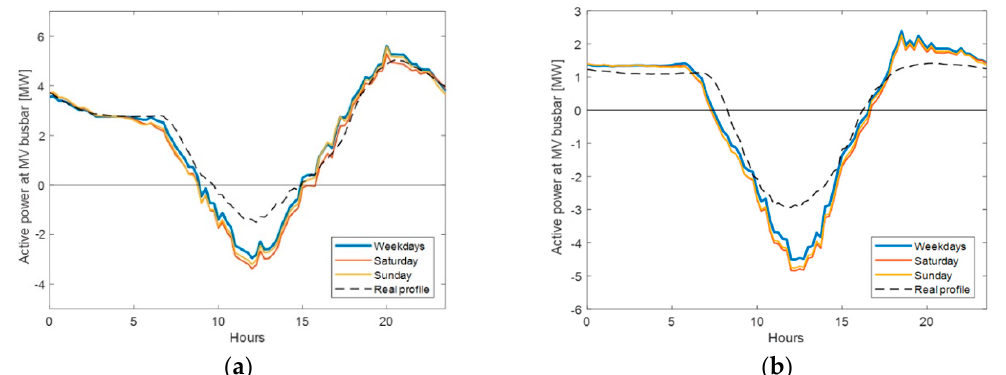
Figure 4. Active power at MV side of the primary ESS for fast growth scenario during spring ( a ) and summer ( b ) considering the impact of Home stations, pole stations and super-fast stations.